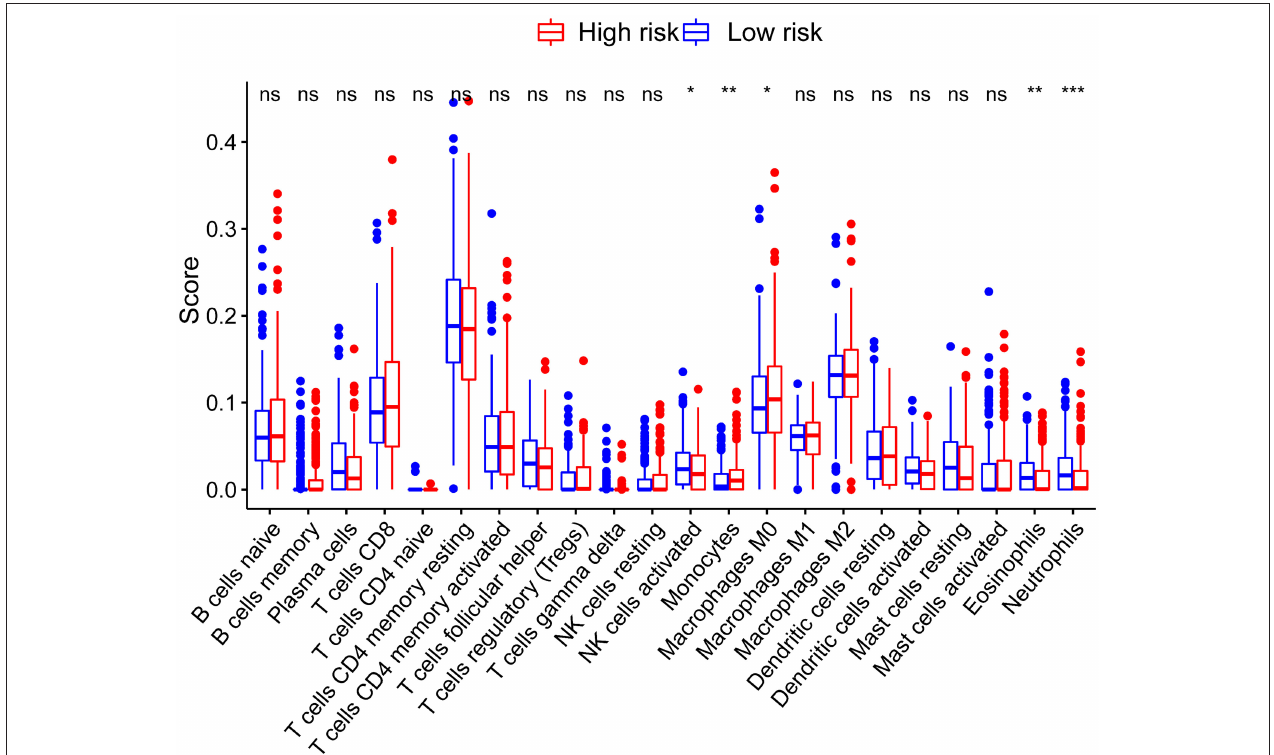
FIGURE 6 | Correlations between the risk score model and tumor-infiltrating immune cells. * P < 0.05; ** P < 0.01; *** P <